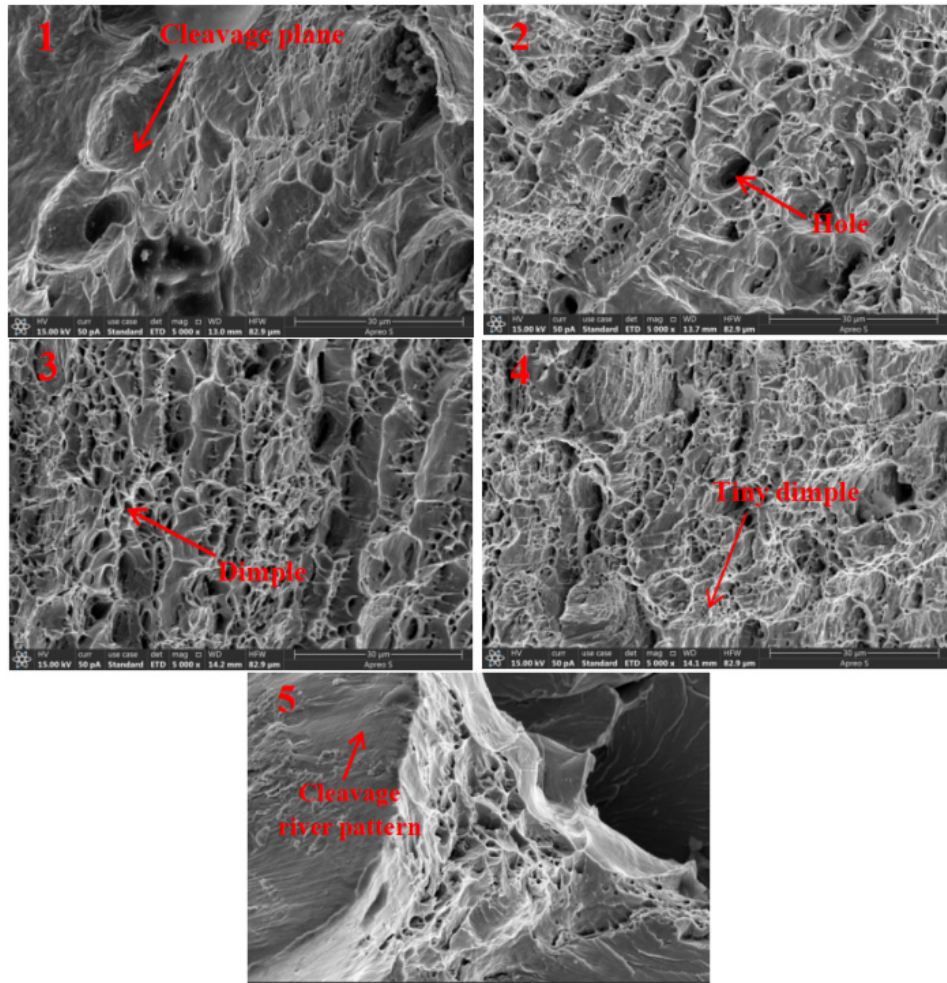
Figure 25. Tensile fracture morphology at different heat treatment temperatures: ( 1 ) as-welded, ( 2 ) 720 °C, ( 3 ) 770 °C, ( 4 ) 820 °C, ( 5 ) 870 °C.